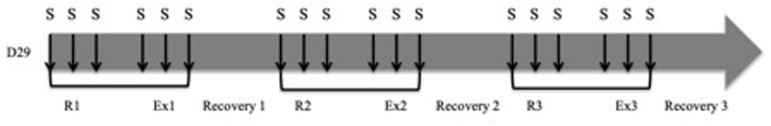
Chronology of experimental interventions: 3 consecutives sequences (R, rest; Ex, exercise; S, tracheal stimulation).